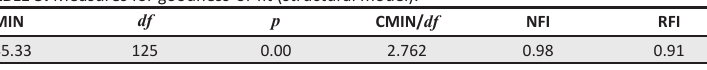
RMSEA, root mean square error of approximation; df , degree of